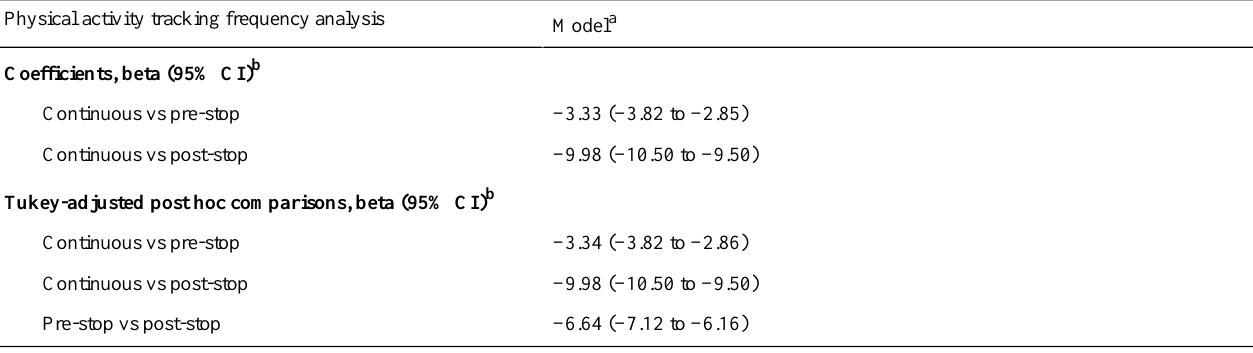
Table 3. Results of the physical activity tracking frequency analysis of research question